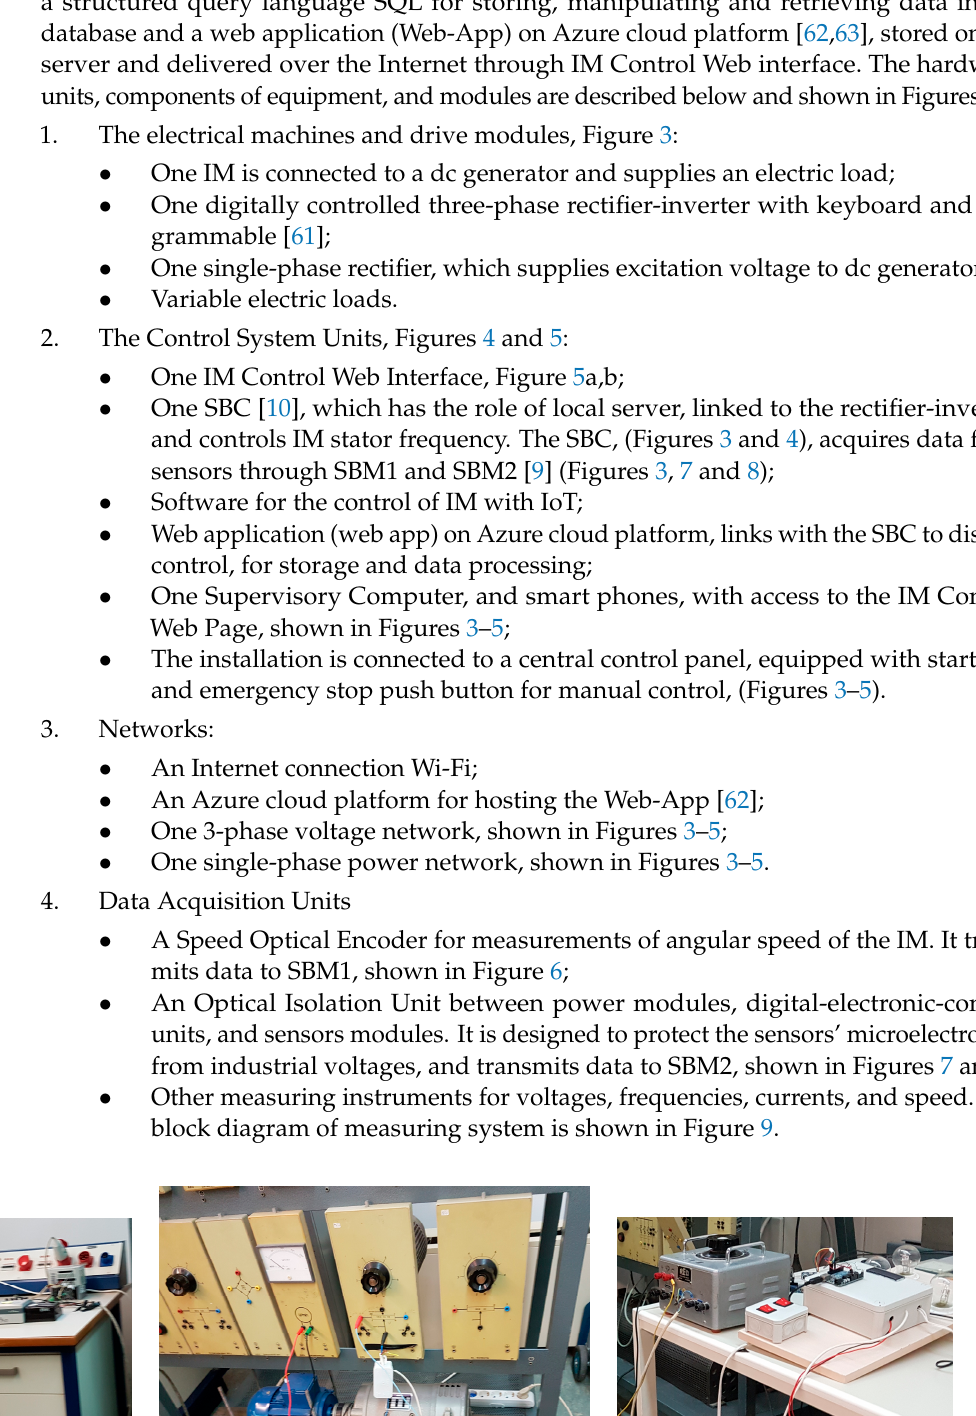
Figure 4. Experimental System (details): SBC, monitor, keyboard, mouse, inverter, adapter USB- RS485, voltmeter, central control panel. ( a ) ( b ) Figure 5. Experimental system (details): ( a ) monitor, keyboard, inverter, adapter USB-RS485, volt- meter, ammeter, power supply network, central control panel; and ( b ) IM Control Interface.